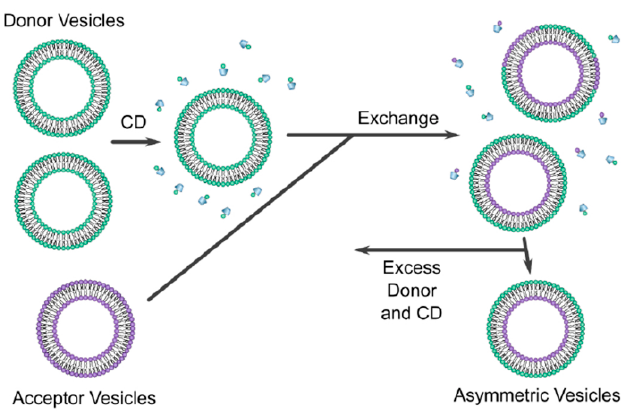
Figure 6. “Schematic of the CD protocol used to prepare asymmetric vesicles” [59] [Reuse permitted by Creative Commons Attribution License (CC BY)]. by Creative Commons Attribution License (CC